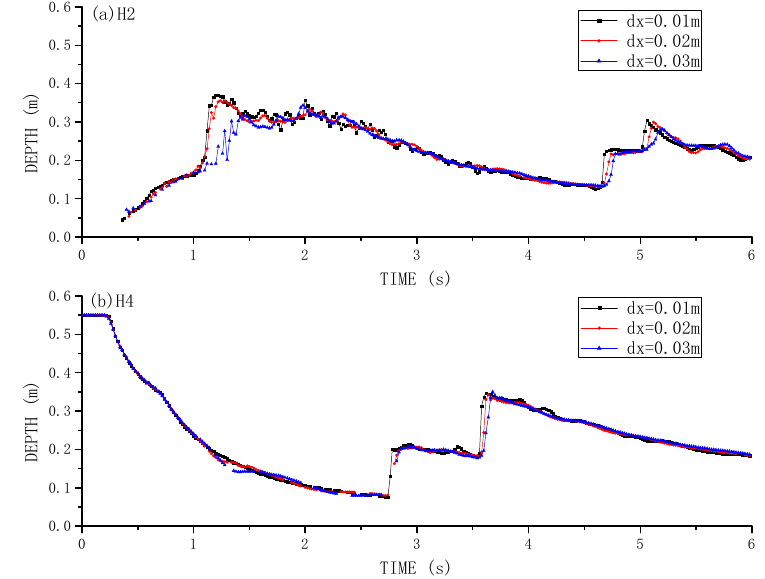
Figure 8. Time histories of dam break flow surface profile at gauging points for three SWE-SPHysics modeling results on [21] at: ( a ) H2; and ( b ) H4.